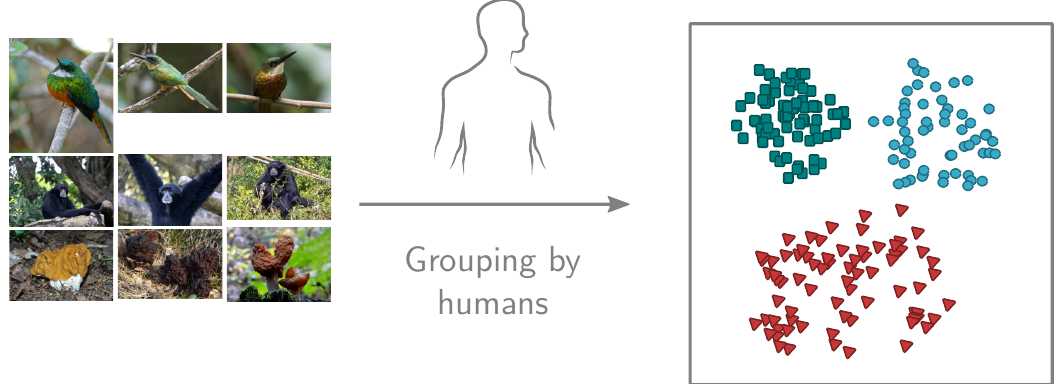
Figure 4. The participants in Task 2 label the images as they see fit. <jacamar> photos by Bernard Dupont licensed under CC BY-SA 2.0 and by David Surtees licensed under CC BY 2.0. <siamang> photos by cuatrok77 licensed under CC BY-SA 2.0 and by Abi Skipp licensed under CC BY 2.0. <gyromitra> photos by Tatiana Bulyonkova licensed under CC BY-SA 2.0 and by Andrey Gaverdovsky licensed under CC BY 2.0. 3.3. Deriving CRT operations